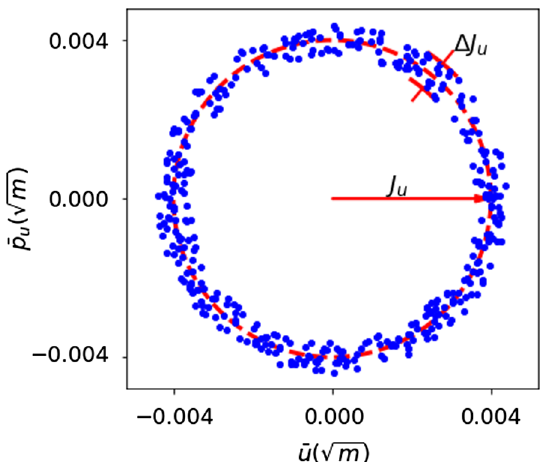
FIG. 2. The root means squared (rms) spread of action from a constant is used as an optimization objective. The dashed circle represents a constant linear action at different angles. The dots are the normalized turn-by-turn